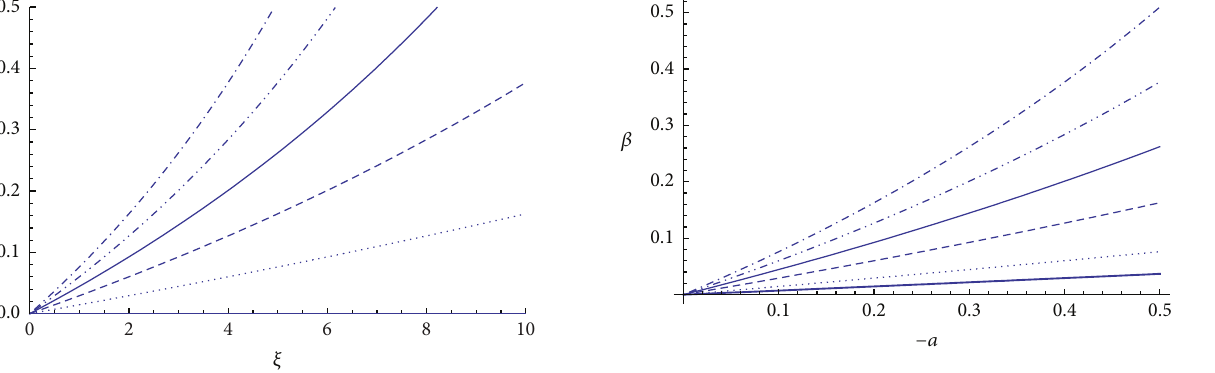
Figure 5: The asymmetry parameter 𝛽 = Λ 𝑡 /Λ 𝑟 as a function of 𝑎 for values of 𝜉(𝑟 𝑠 ) = (1, 2, 4, 6, 8, 10)/2 . In the plots 𝜉(𝑟 𝑠 ) is increasing upwards. Note that, on the x -axes, the opposite of 𝑎 is